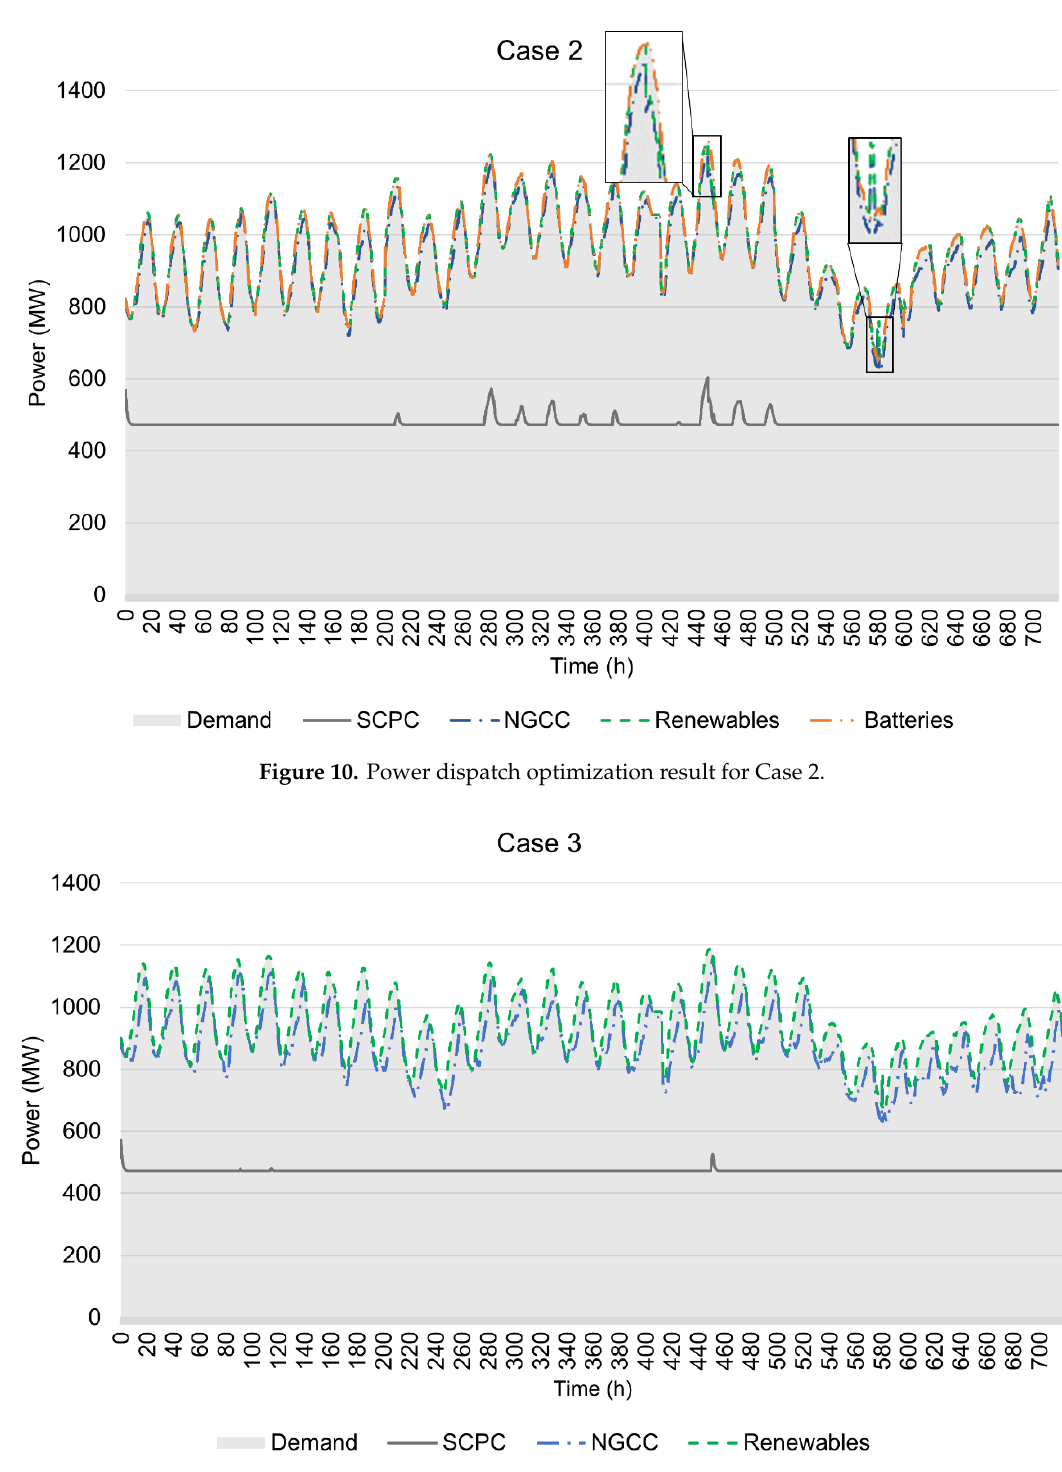
Figure 9. Power dispatch optimization result for Case 1.